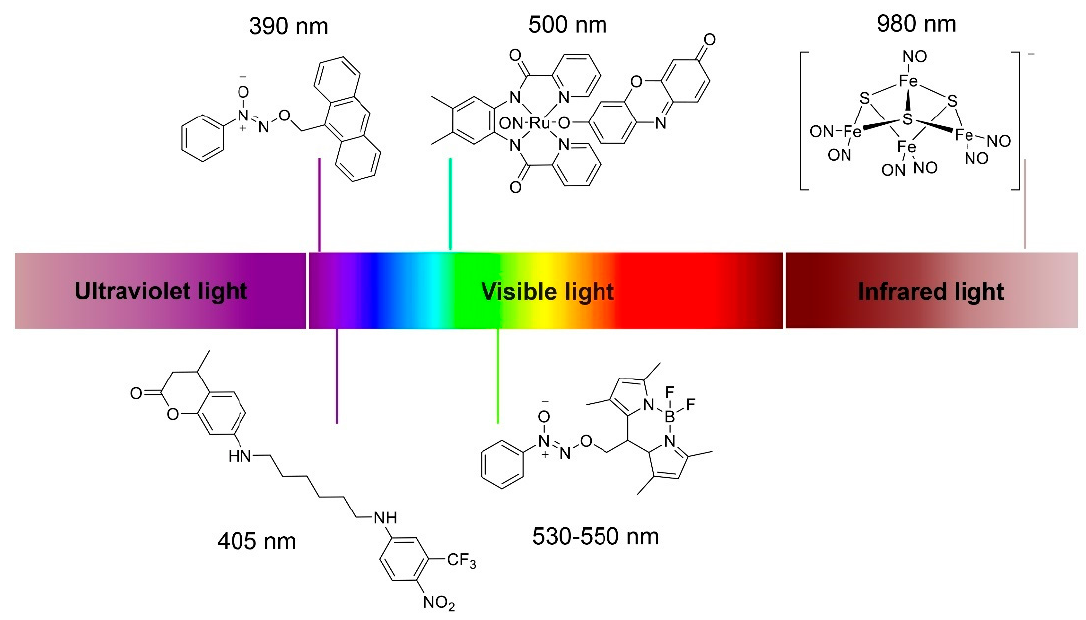
Figure 7. Chemical structures of small molecule photoresponsive NO donors triggered by visible light or near-infrared light.